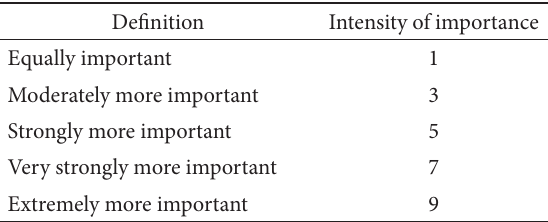
Table 1. Nine-point intensity of importance scale and its description (Dağdeviren 2008)